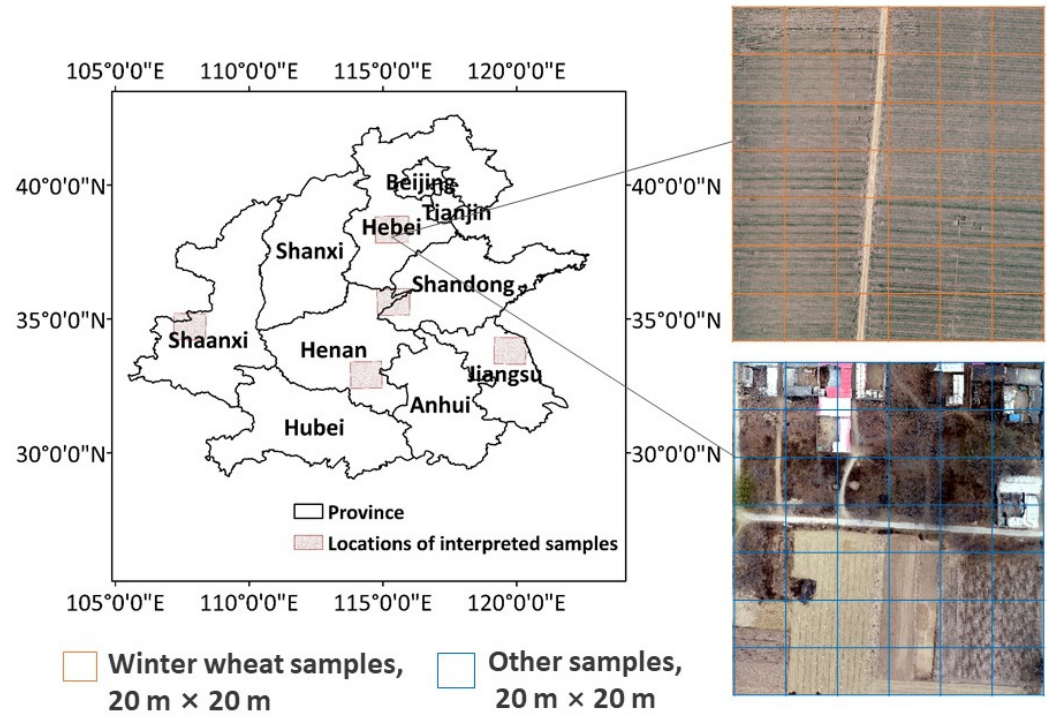
Figure 3. Samples interpreted using high-resolution imagery.